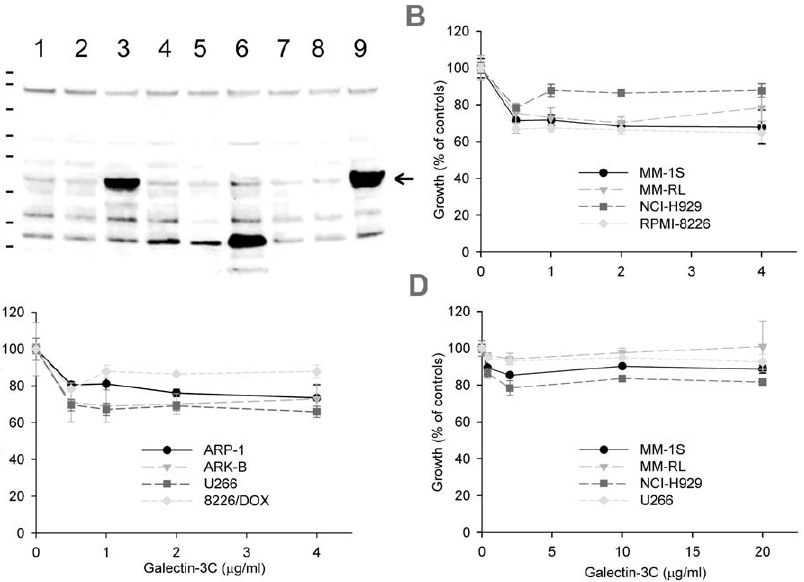
Figure 1. Galectin-3 expression levels in MM cell lines and effects of galectin-3 inhibition invitro. ( a ) The lysates in each lane are as follows: 1 MM-1S; 2 MM-1RL; 3 NCI-H929; 4 RPMI-8226; 5 Dox-40; 6 LR-5; 7 ARP-1; 8 ARB-B; 9 U266. Indicated MM cell lines were seeded at 300,000 cells/mL and maintained at 37 u C and 5% CO 2 . Total protein fractions from exponentially growing cells were prepared and analyzed by immunoblot to detect galectin-3. Galectin-3 monomers are approximately 30 kDa (arrow). Detection of bands at higher and lower masses is consistent with reports of the multimerization of the protein and its digestion by matrix metalloproteinases. ( b ) Graph of the results from proliferation assays shows the relative responses of MM-1S, MM-RL, NCI-H929, and RMPI-8266 and, ( c ) ARP-1, ARK-B, U266, and 8226/Dox cells to 0.5, 1, 2, or 4 m g/ml Gal-3C compared to control wells over 48 h. There was a significant decrease in proliferation in response to Gal-3C treatment (defined as P , 0.05; t -test) in all eight cell lines at one or more concentrations 48 h. Triplicate data points were analyzed and the data shown are representative of 3 or more experiments. Error bars are 6 SD. ( d ) Graph of the results from proliferation assays with MM-1S, MM-RL, NCI-H929, and U266 showing the relative response to 0.4, 2, 10,or 20 m g/ml Gal-3C compared to control wells over 24 h. There was a significant decrease ( P , 0.01) in proliferation of MM-1S, NCI-H929, and U266 cells in response to Gal-3C at one or more concentration after 24 h. Error bars are 6 S.D.